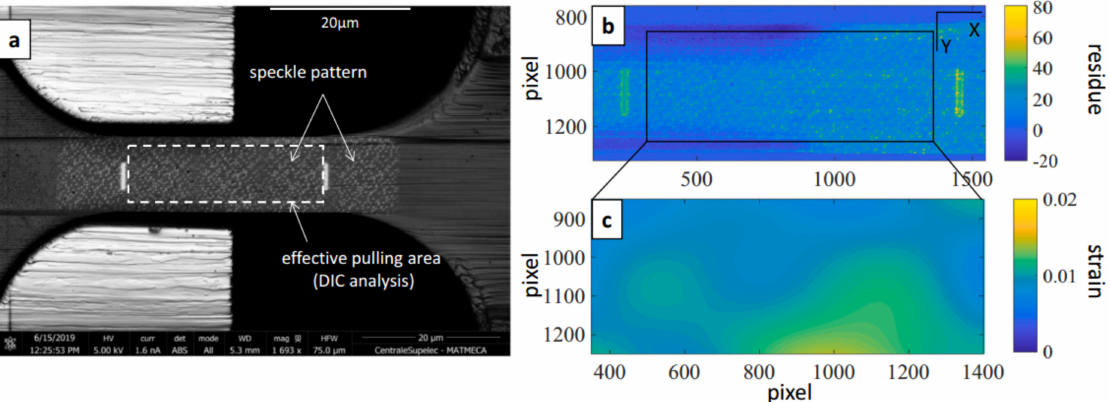
Figure 14. ( a ) The DIC analysis system; ( b ) the residue of the correlation (in % of grey level); ( c ) the determined strain field in the tensile direction